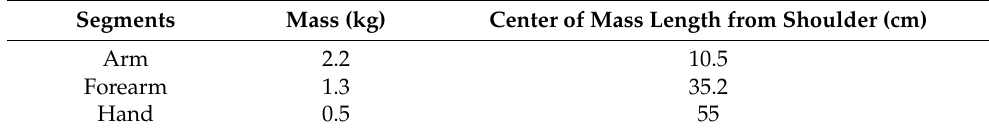
Table 2. Length and mass values of the upper limb segments.